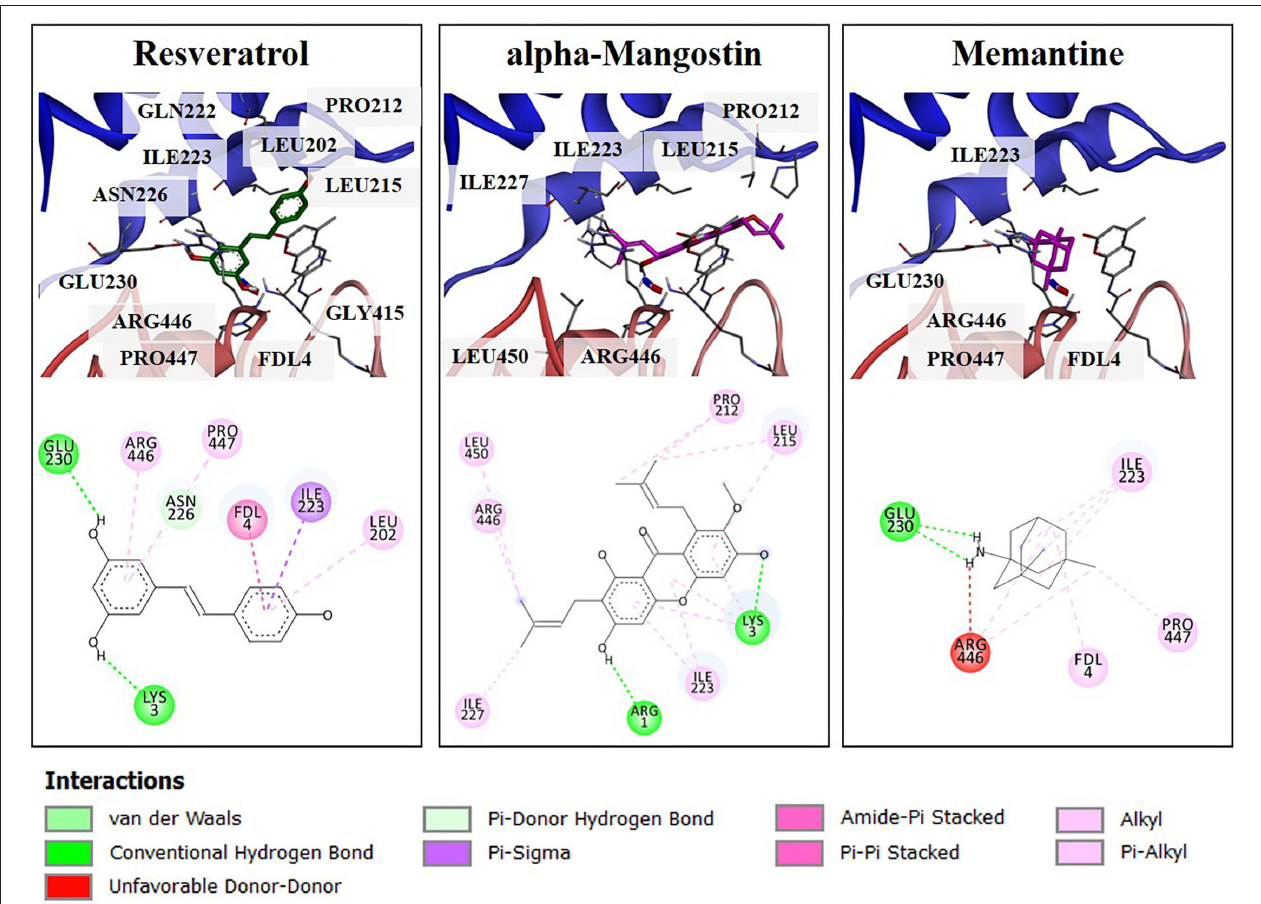
FIGURE 6 | The 3D illustrations of different binding modes of resveratrol, alpha-mangostin, and memantine in SIRT1 activator binding site (PDB code 5BTR). The amino acid residue (carbon colored gray), resveratrol (carbon colored green), and compound interest (carbon colored magenta) are shown in a stick model. The 2D structure of compounds was drawn in a black line. The interaction of residues was represented as a colored ball according to different types of interactions.